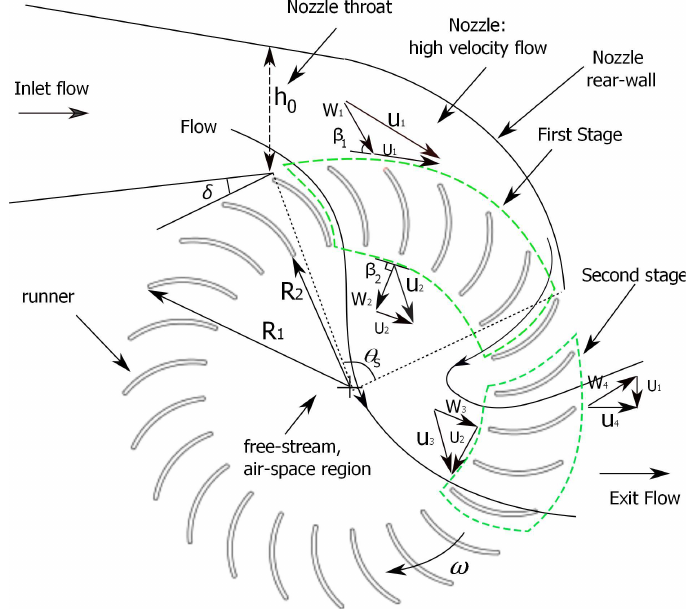
Figure 1. Schematic illustration of key geometrical parameters of crossflow turbine